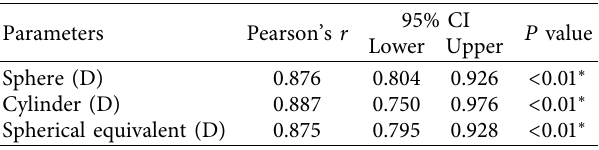
Figure 2: (a) Frequency distribution of spherical equivalent with cycloplegic retinoscopy measurement. (b) Frequency distribution of spherical equivalent with 2WIN-S photorefractometer measurement. Table 2: Correlation between cycloplegic retinoscopy and 2WIN-S